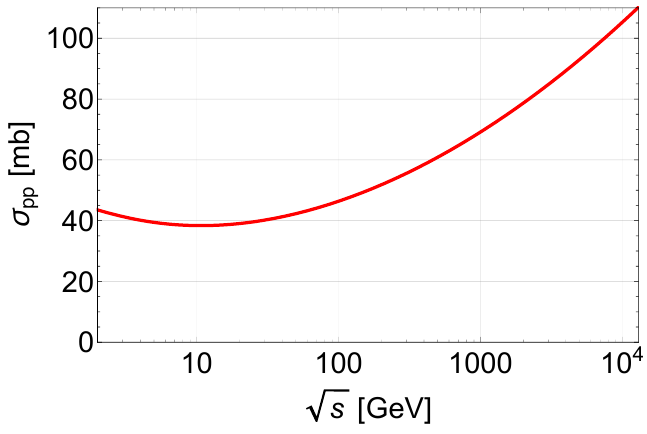
Figure 16 . Proton-proton total cross section as a function of the center of mass energy p s pp